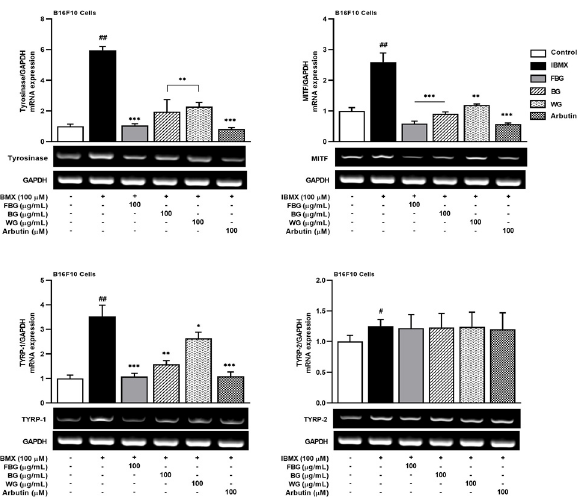
Figure 2. Effect of FBG, BG, and WG on anti-melanogenic mechanism. The B16F10 cells were treated with 100 µ g/mL of FBG, BG, or WG for 72 h. The expression of tyrosinase, TYRP-1, TYRP-2, and MITF at the mRNA level was determined using qRT-PCR. Arbutin (100 µ M) was used as a positive control. The graph shows mean ± SD values of three replicates. # p < 0.05, ## p < 0.01, as compared with control group; * p < 0.05, ** p < 0.01, *** p < 0.001, as compared with the IBMX-induced group.